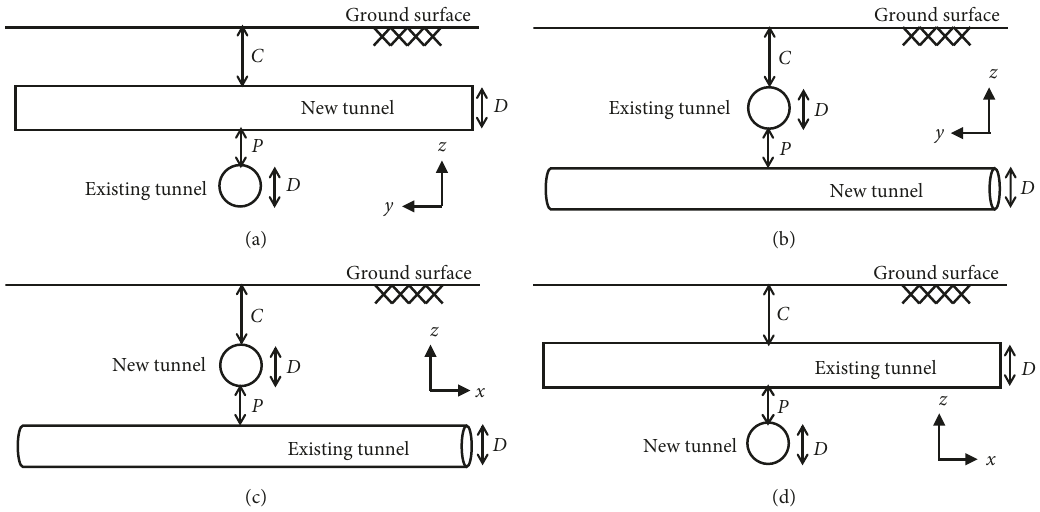
Figure 2: Elevation views of S1 and S2 (schematic diagram). (a) Tunnelling sequence S1 (Section A-A). (b) Tunnelling sequence S2 (Section A-A). (c) Tunnelling sequence S1 (Section B-B). (d) Tunnelling sequence S2 (Section B-B).